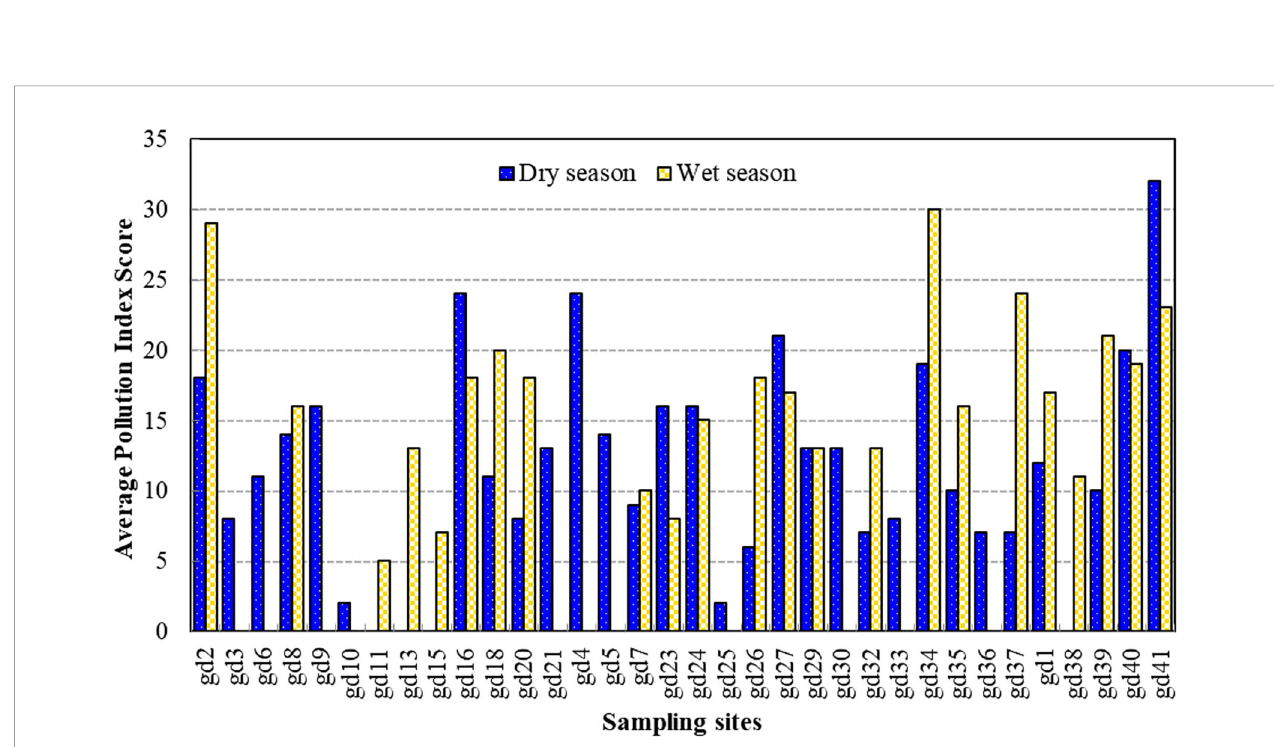
FIGURE 6 | The temporal and spatial variation of the algal species pollution index score during the study